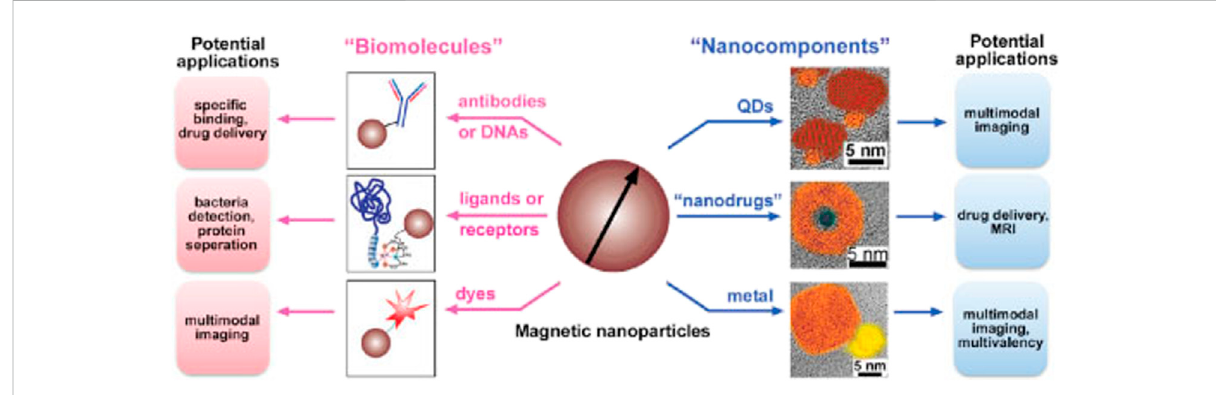
The scheme illustrates two strategies to fabricatemultifunctional magnetic nanoparticlesand theirpotential applications.Reproducedfrom ref 30. Copyright 2003 American Chemical